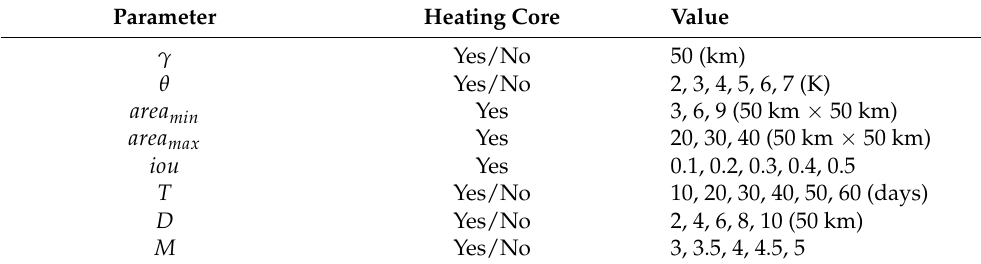
Table 2. Candidate parameters for models with/without a “heating core” when the resampling scale is 50.